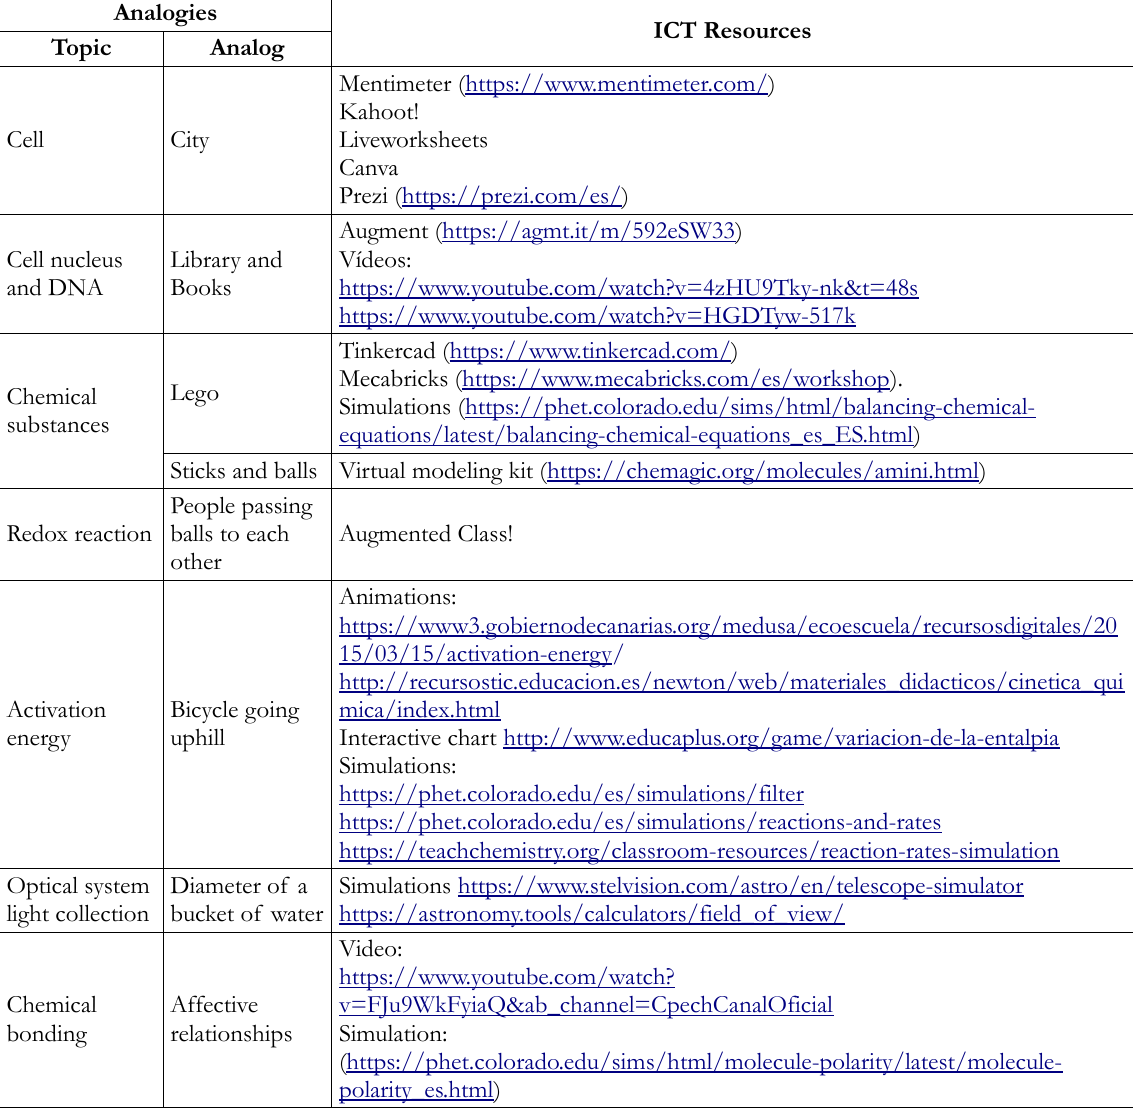
Table 4. Summary of analogies and ICT resources proposed in the students’ final